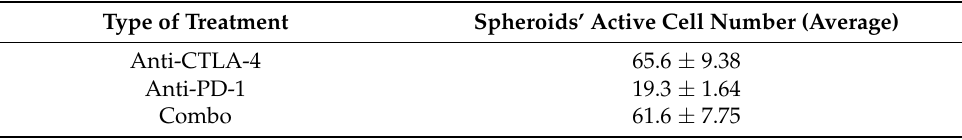
Table 2. Reinvigorated cell counts in checkpoint blockade